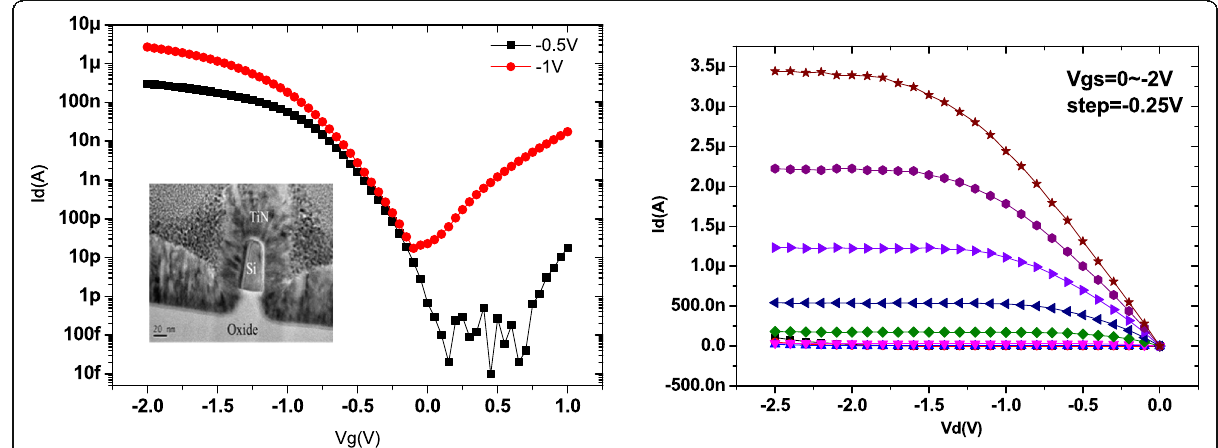
Fig. 11. The insets show the output and transfer charac- teristics of the unexpected Si JL-FET after Ge overetch- ing; the I / I ratio of this device is as high as 10 8 . on off However, its ON current is only 17 μ A μ m − 1 at − 1 V. The high I / I ratio is attributable to the Si layer and on off not the Ge layer. When only the Si layer is left, the device is actually a Si JL-FET rather than a Ge